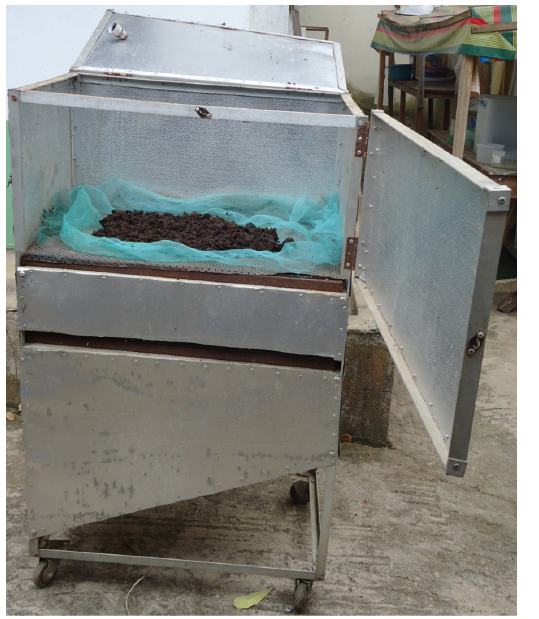
Fig. 4. Wooden boxes used for production of